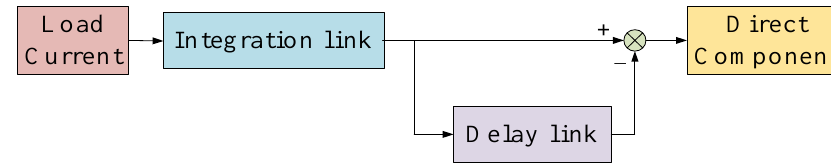
Figure 7. Average current filtering process.